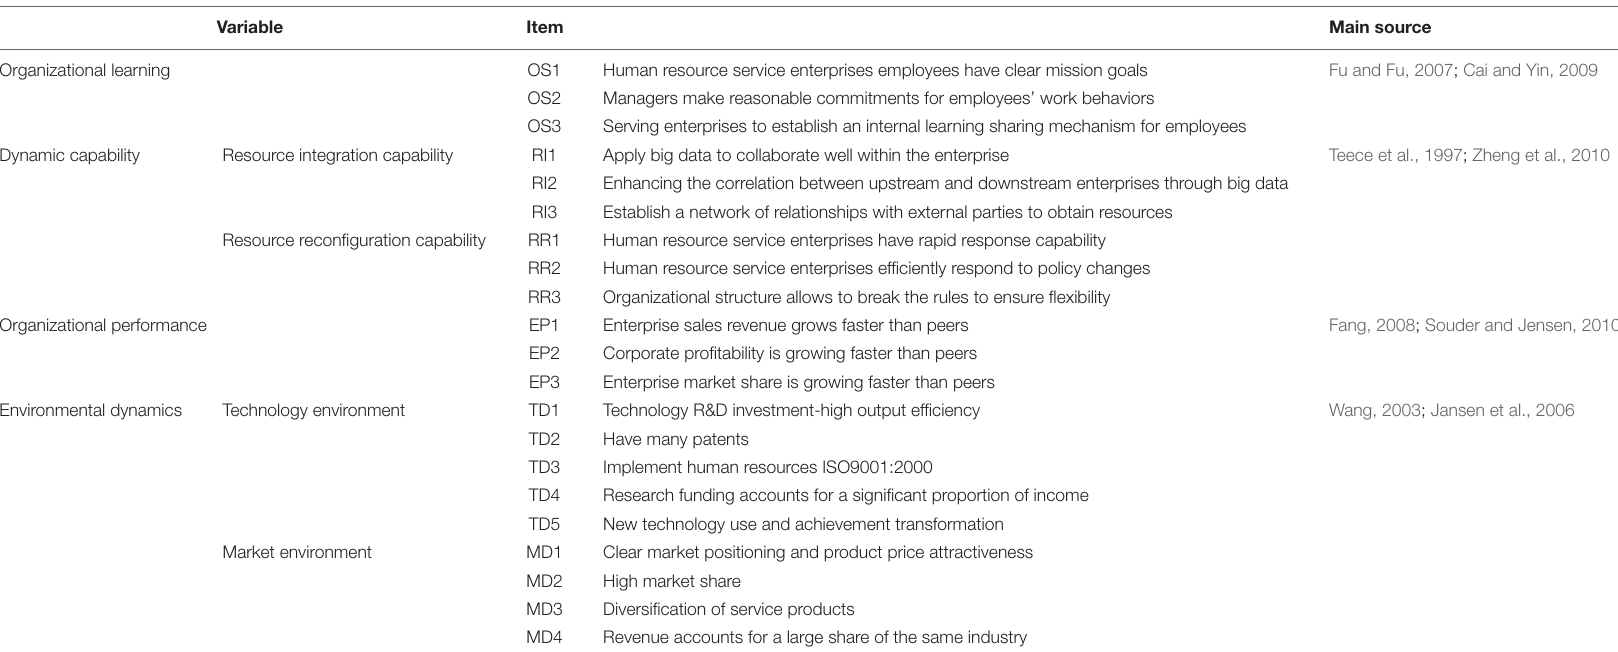
TABLE 2 | Related variables measurement items. Variable